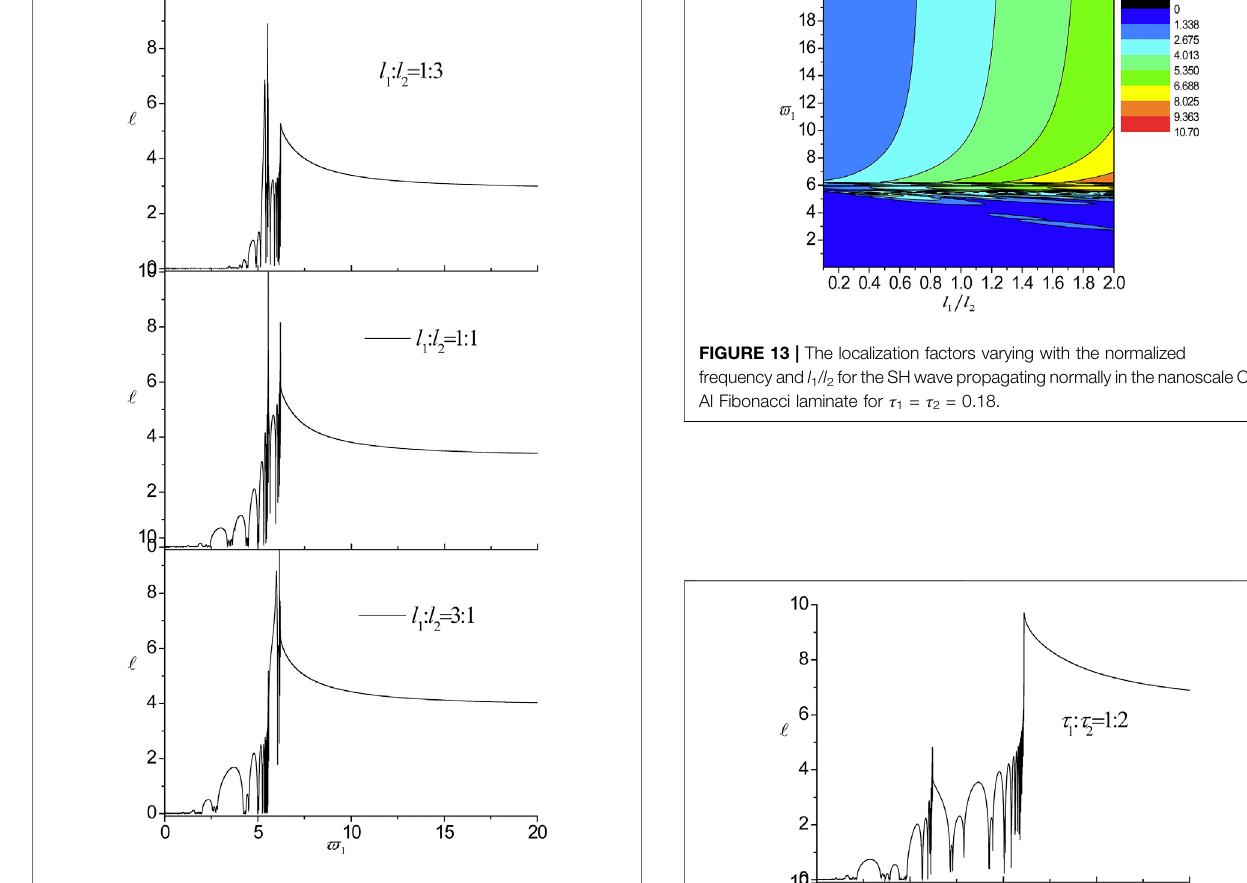
FIGURE 12 | The in fl uences of the ratio of external characteristic thickness on localization factors in the nanoscale Fibonacci systems consisting of Cu/Al for τ 1 = τ 2 = 0.18.